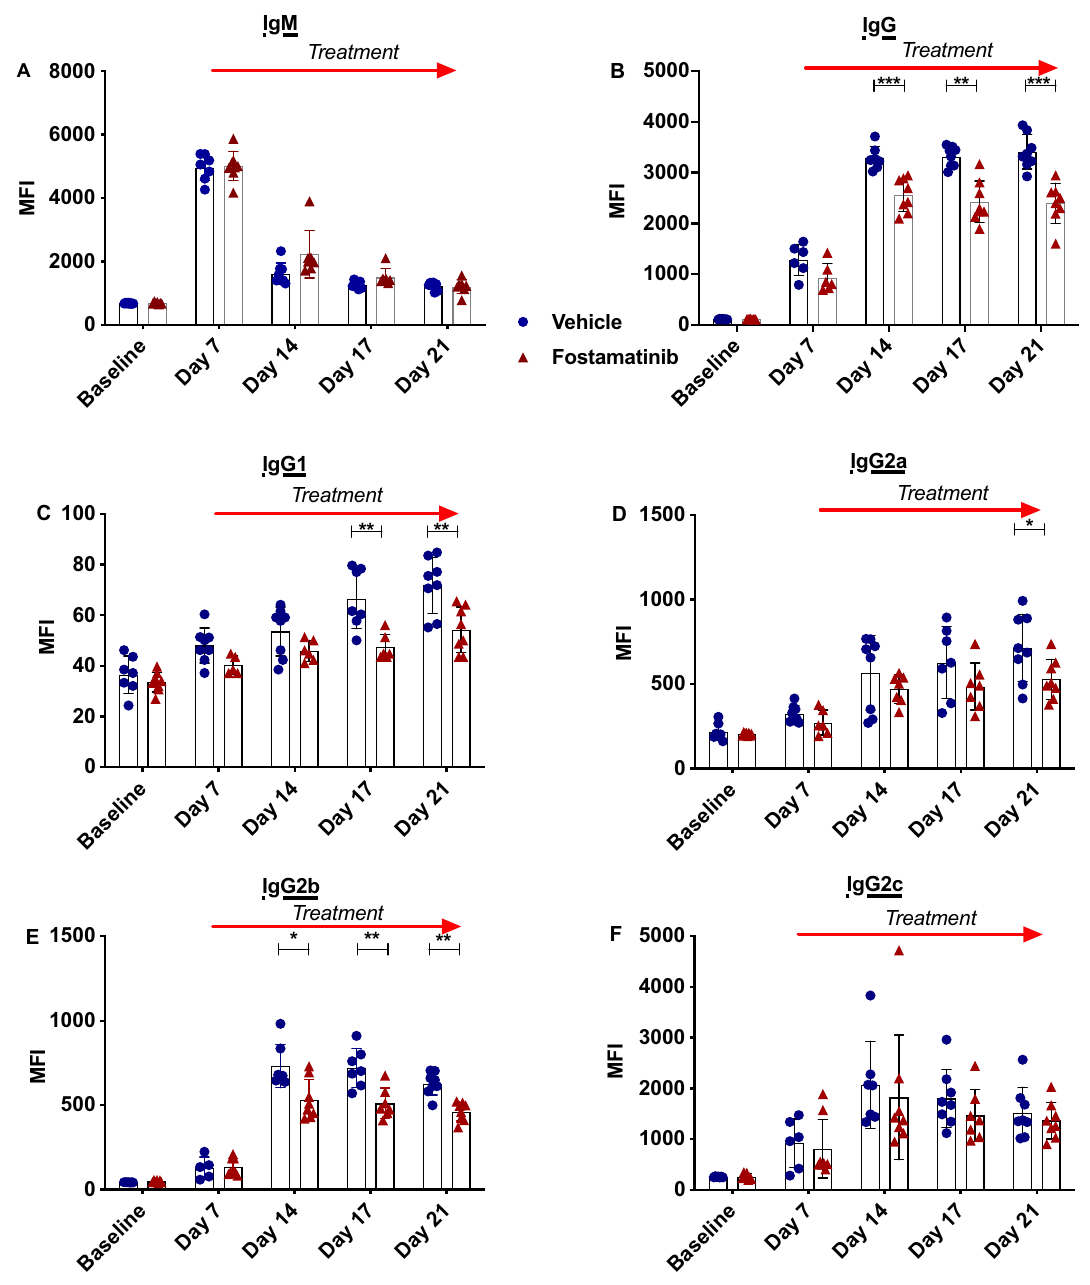
Figure 6. Delayed fostamatinib treatment reduces levels of DSA IgG in sensitised rats. T lymphocyte crossmatch analysis was performed to detect DSA levels in sensitized fostamatinib and vehicle treated LEW rats. Treatment initiation was delayed until 7 days post-transfusion. ( A ) IgM levels remained the same in both treatment groups. ( B ) Circulating allogenic IgG levels were significantly lower in fostamatinib treated rats at days 14, 17 and 21 post-transfusion. ( C ) From 17 days onwards IgG1 levels were significantly lower in fostamatinib treated animals, from 14 days onwards IgG2a ( D ) levels were significantly lower in fostamatinib treated animals, and by 21 days post-transfusion IgG2b ( E ) levels were significantly lower in fostamatinib treated animals. No differences were observed in IgG2c levels at any measured time point ( F ) (n = 6 rats/group) *P ≤ 0.05, **P ≤ 0.01, ***P ≤ 0.001). Blue filled circle—vehicle, red filled